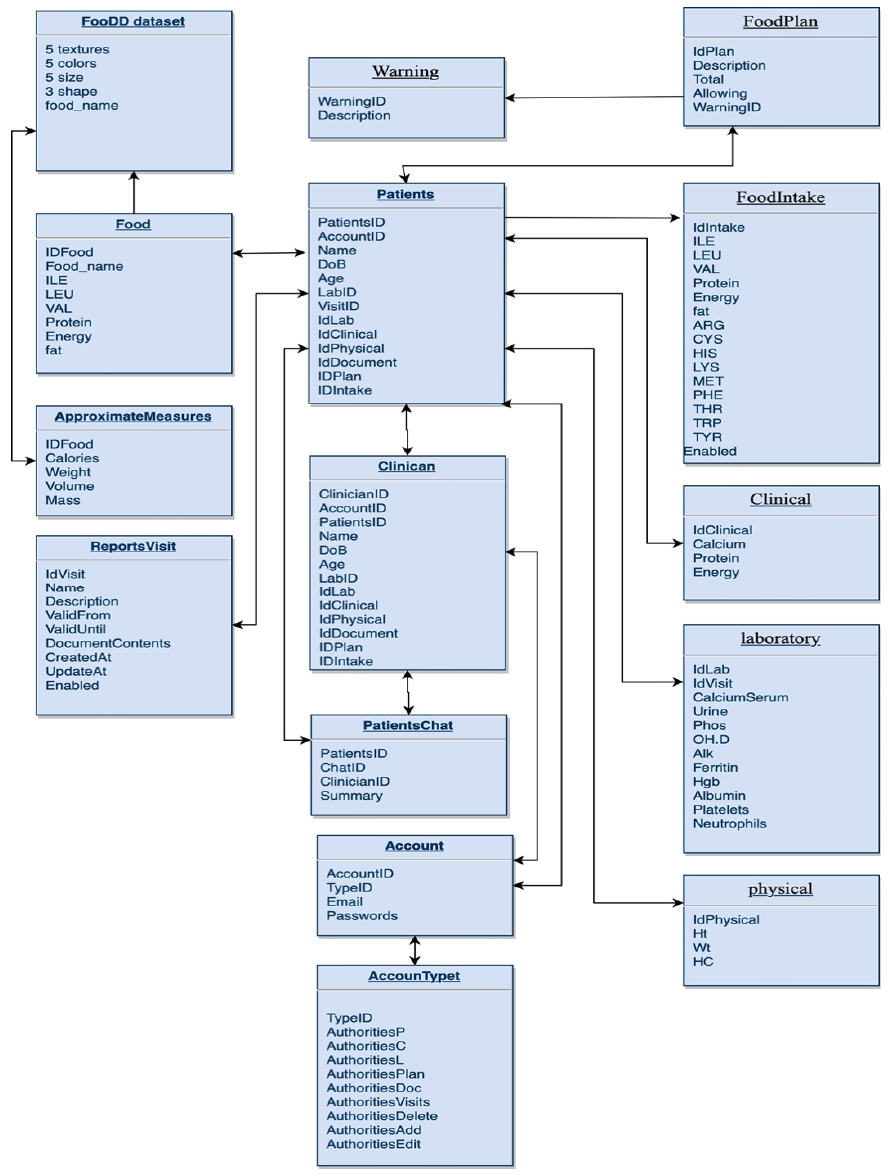
Figure 3. MSUD Database Schema.